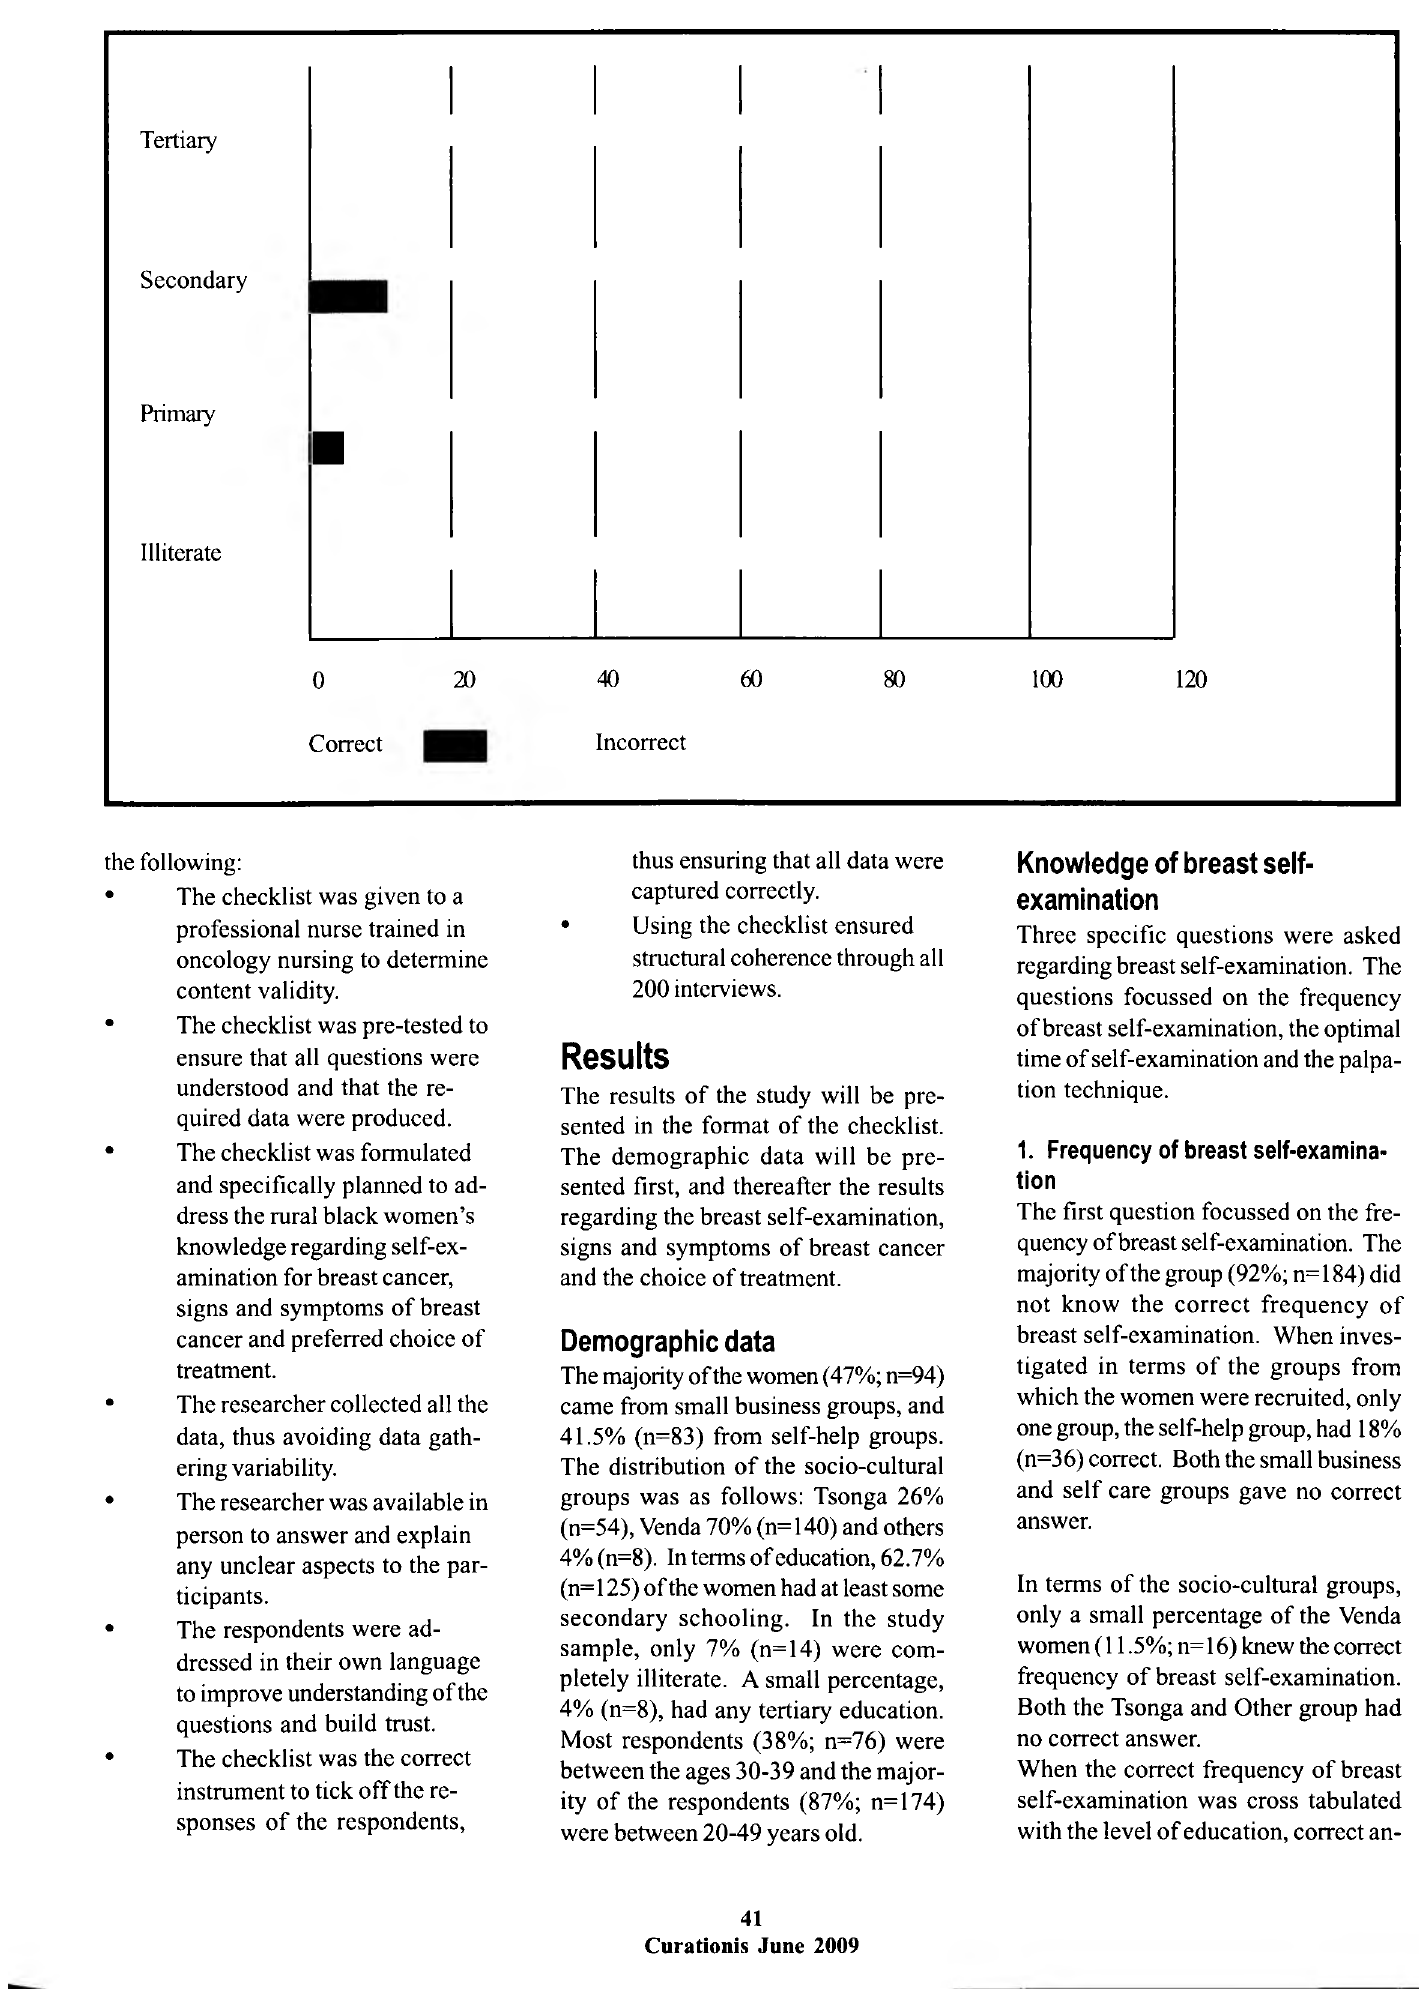
FIGURE 1: Level of education and knowledge of correct frequency of breast